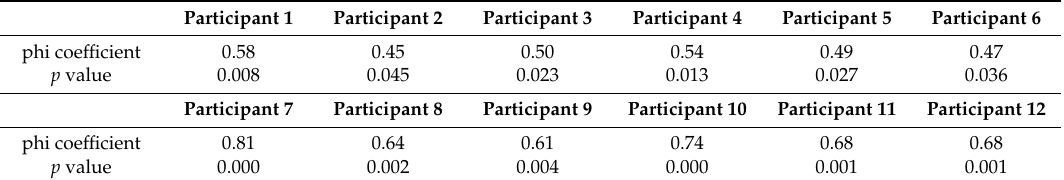
Table 6. Correlation of spontaneous facial a ff ect and a ff ect state translated by participants’ brain signals triggered by image stimuli.